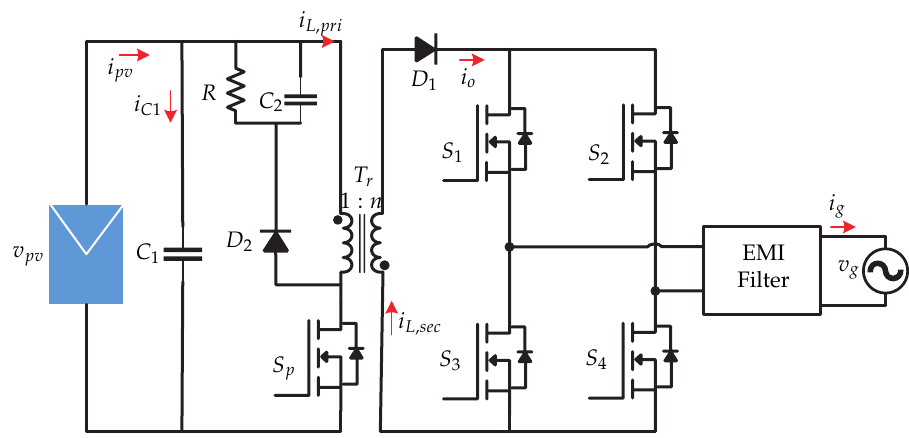
Figure 10. Microinverter’s topology proposed in [19,20].